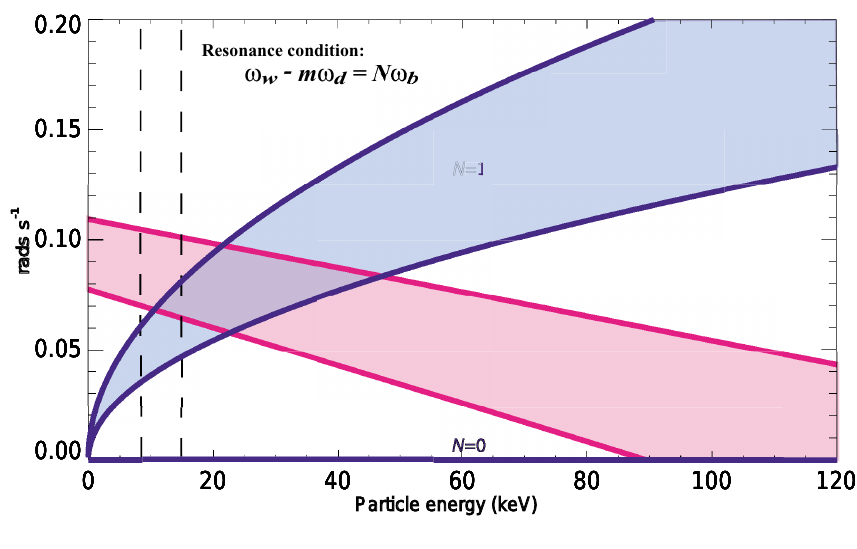
Fig. 6. A graphical representation of the drift-bounce resonance condition (see text for details). It can be seen that the two shaded areas intersect at two loca- tions, with these locations revealing the energies at which the resonance condi- tion is satisfied. If free energy is avail- able to the wave at these interaction en- ergies in the form of a positive gradient in the IDF, then the particle population can provide energy for that wave mode. The dashed vertical lines represent the upper and lower particle energies of the positive gradient ( ∂f/∂W > 0) as mea- sured by the CAMMICE (MICS) in- strument onboard the Polar